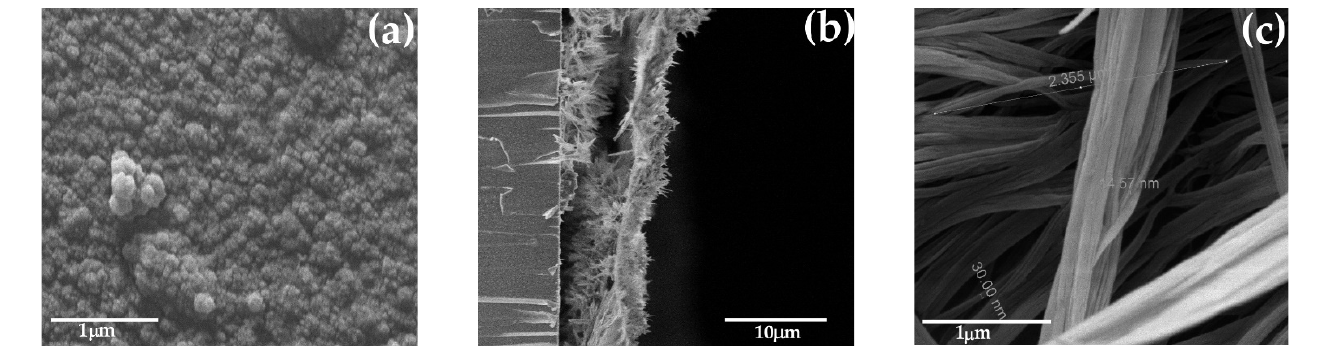
Figure 4. SEM micrographs of PPy: (a) bulk, and (b) and (c) nanowires.